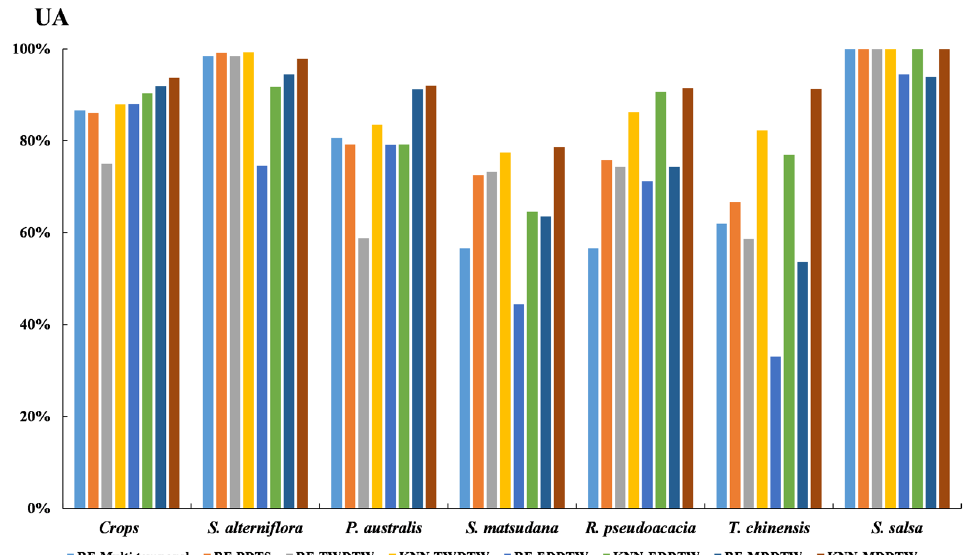
Figure 10. Producer accuracy of different classification methods.